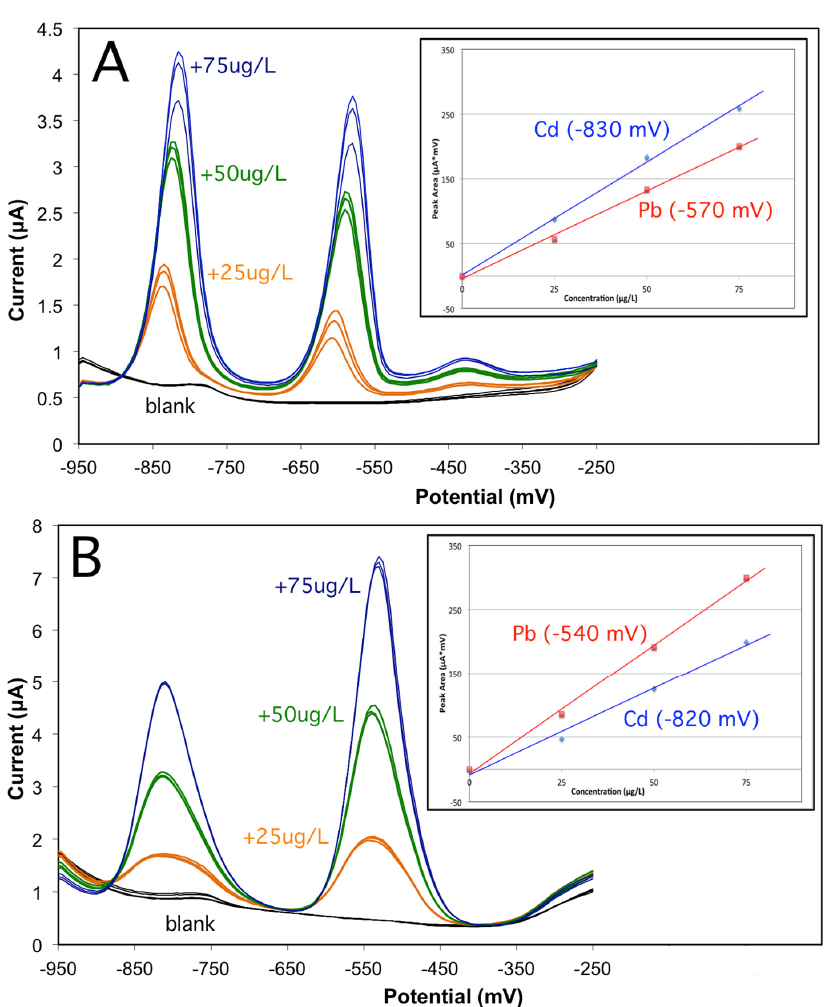
Figure 3. Differential-pulse stripping analysis of cadmium and lead with ( A ) Bi/PO 4 /Naf at pH = 4.4 and ( B ) Bi/PO 4 /PSS(A) at pH = 2. Calibration curves for Cd and Pb are shown in the insert.